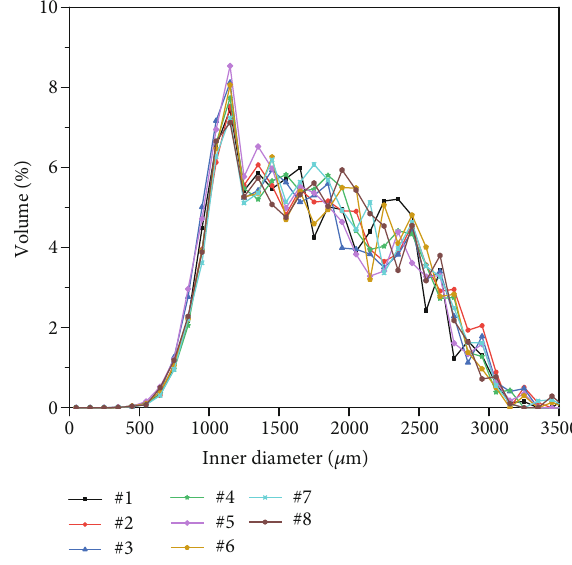
Figure 4: Particle size distribution curve of repeated measurement for 8 times (coal sample mass = 5